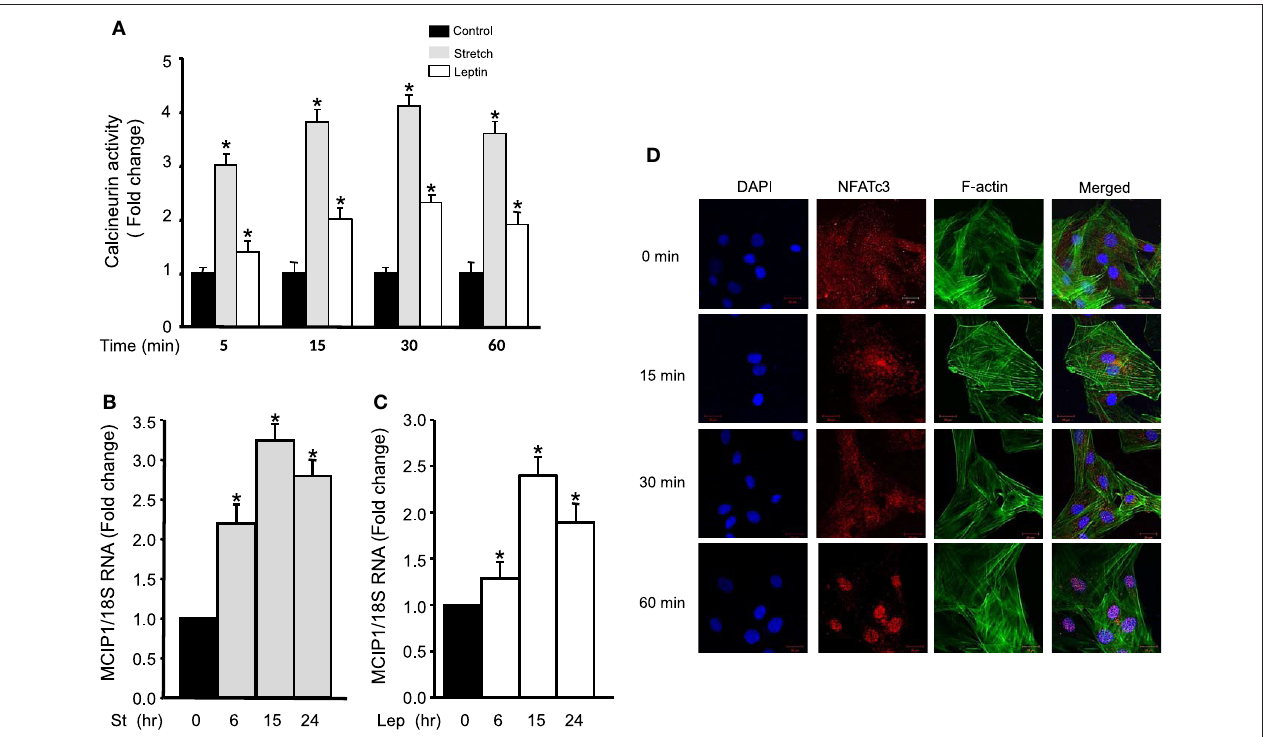
FIGURE 3 | Mechanical stretch/leptin activate calcineurin/NFAT and MCIP1 gene expression. (A) RPVs were either mechanically stretched or treated with leptin (3.1nM) for 5, 15, 30, or 60min, followed by measuring the phosphatase activity of calcineurin, using a kit. Mechanical stretch and leptin each significantly activated calcineurin, with peak activation after 30min ( n = 8–9). * p < 0.05 vs. control. (B) RPVs were stretched for 6, 15, or 24h followed by Real-Time PCR. MCIP1 mRNA expression was significantly increased in response to mechanical stretch. (9–10). * p < 0.05 vs. unstretched (0h). (C) RPVs treated with leptin (3.1nM) for 6, 15, or 24h significantly upregulated MCIP1 mRNA expression. (8–10). * p < 0.05 vs. unstretched (0h). (D) Representative laser confocal microscopic images of RASMCs to detect NFATc3 nuclear translocation. DAPI stained the nuclei (left panel; blue). NFATc3 primary antibody was detected by Alexa Fluor 594 goat anti-rabbit secondary antibody (second panel; red). Phalloidin-FITC stained F-actin green (third panel). The overlay of all three signals is shown in the right panel ( n = 4). Time course of leptin treatment showed that 1h of leptin treatment activated NFAT and promoted its nuclear